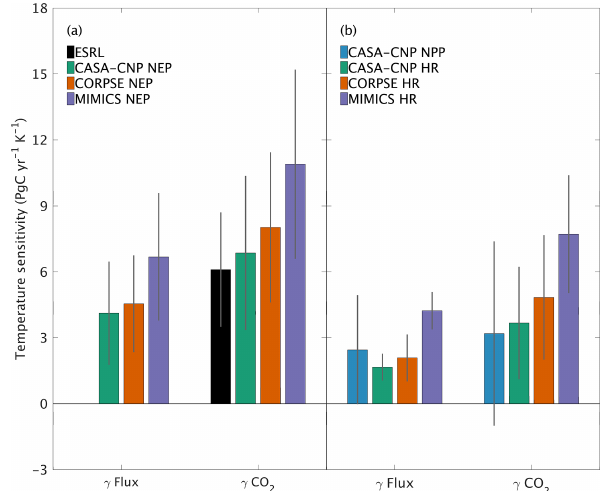
Figure 7. Temperature sensitivity ( γ ) calculated for interannual variability (IAV) of CASA-CNP air temperature and (a) NEP flux IAV and corresponding CO NEP growth rate anomalies and (b) com- 2 ponent flux IAV and CO 2 growth rate anomalies. The reference sen- sitivity value (black) was calculated using NOAA ESRL CO 2 and CRU TS4 air temperature. Sensitivity values were calculated as the ordinary linear regression coefficient between IAV time series for 1982 to 2010. Error bars represent the 95% confidence interval for coefficient